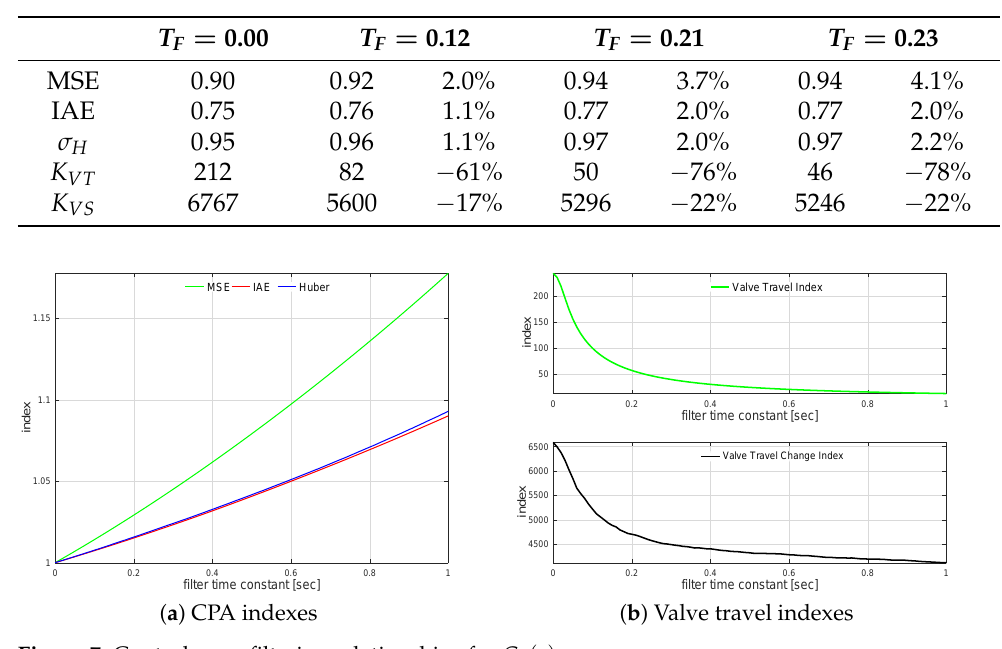
Figure 7. Control error filtering relationships for G 1 ( s ) .